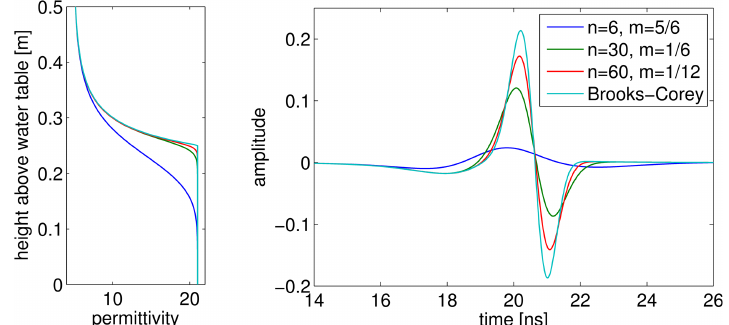
Fig. 7. Full van Genuchten parameterisation (Eq. 2): permittivity profiles (left panel) and corresponding modelled reflections (right panel). Starting from parameters equal to the simplified van Genuchten parameterisation with α =4m − 1 and n =6 (blue), n is increased while n × m =const to sharpen the curve around the air entry. Furthermore, a profile parameterised by the Brooks–Corey parameterisation with h 0 = 1 and λ = n × m (cyan) is shown for α